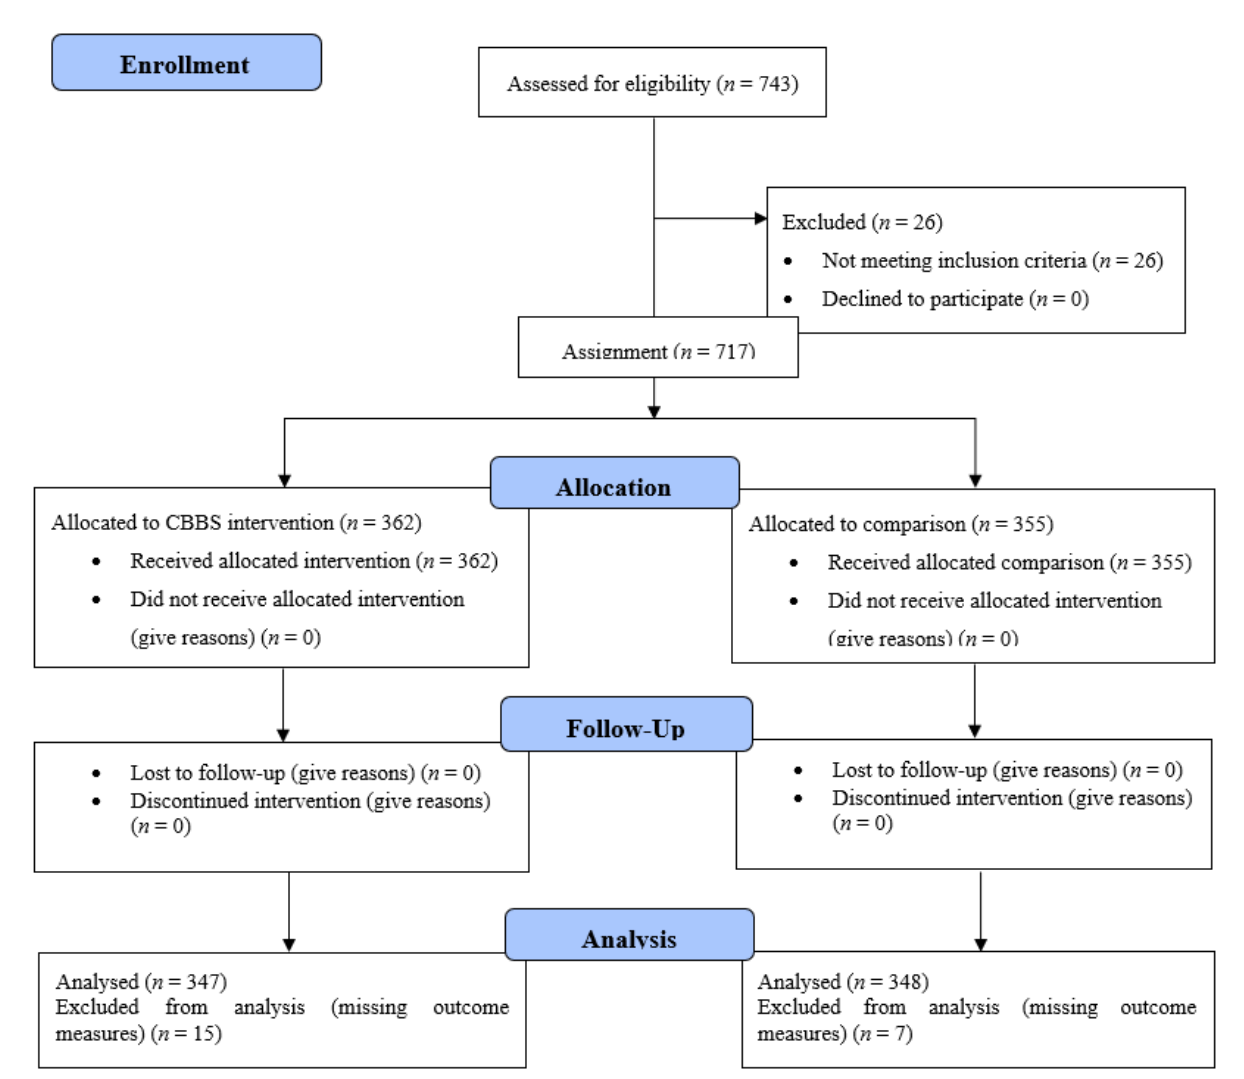
Figure 1. Recruitment and study design diagram.